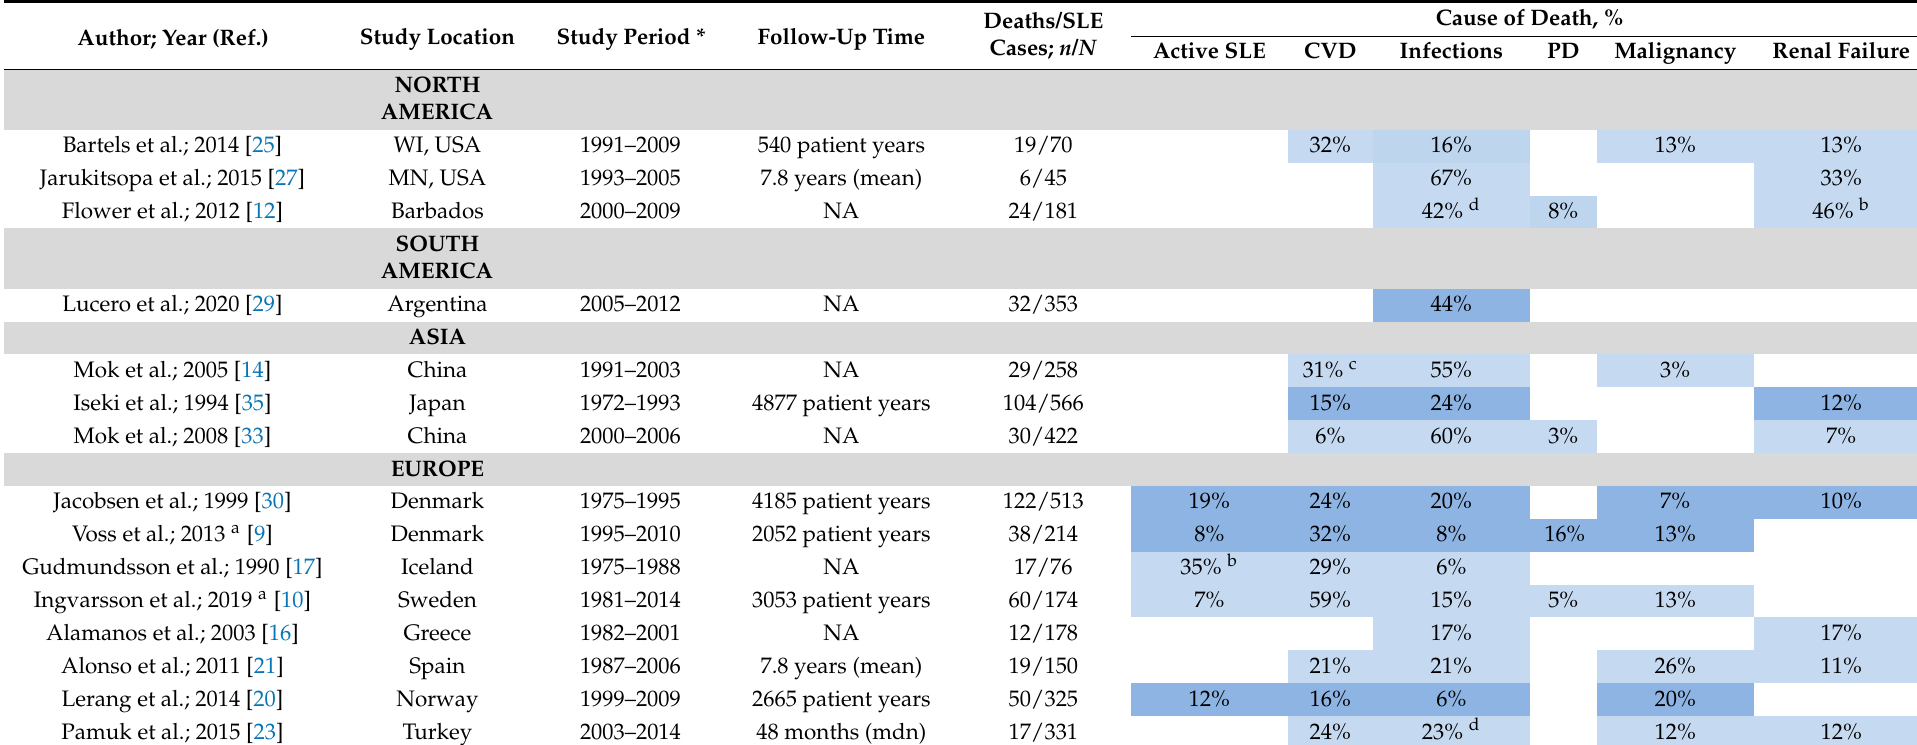
Table 2. The main causes of death in Systemic Lupus Erythematosus, from population-based